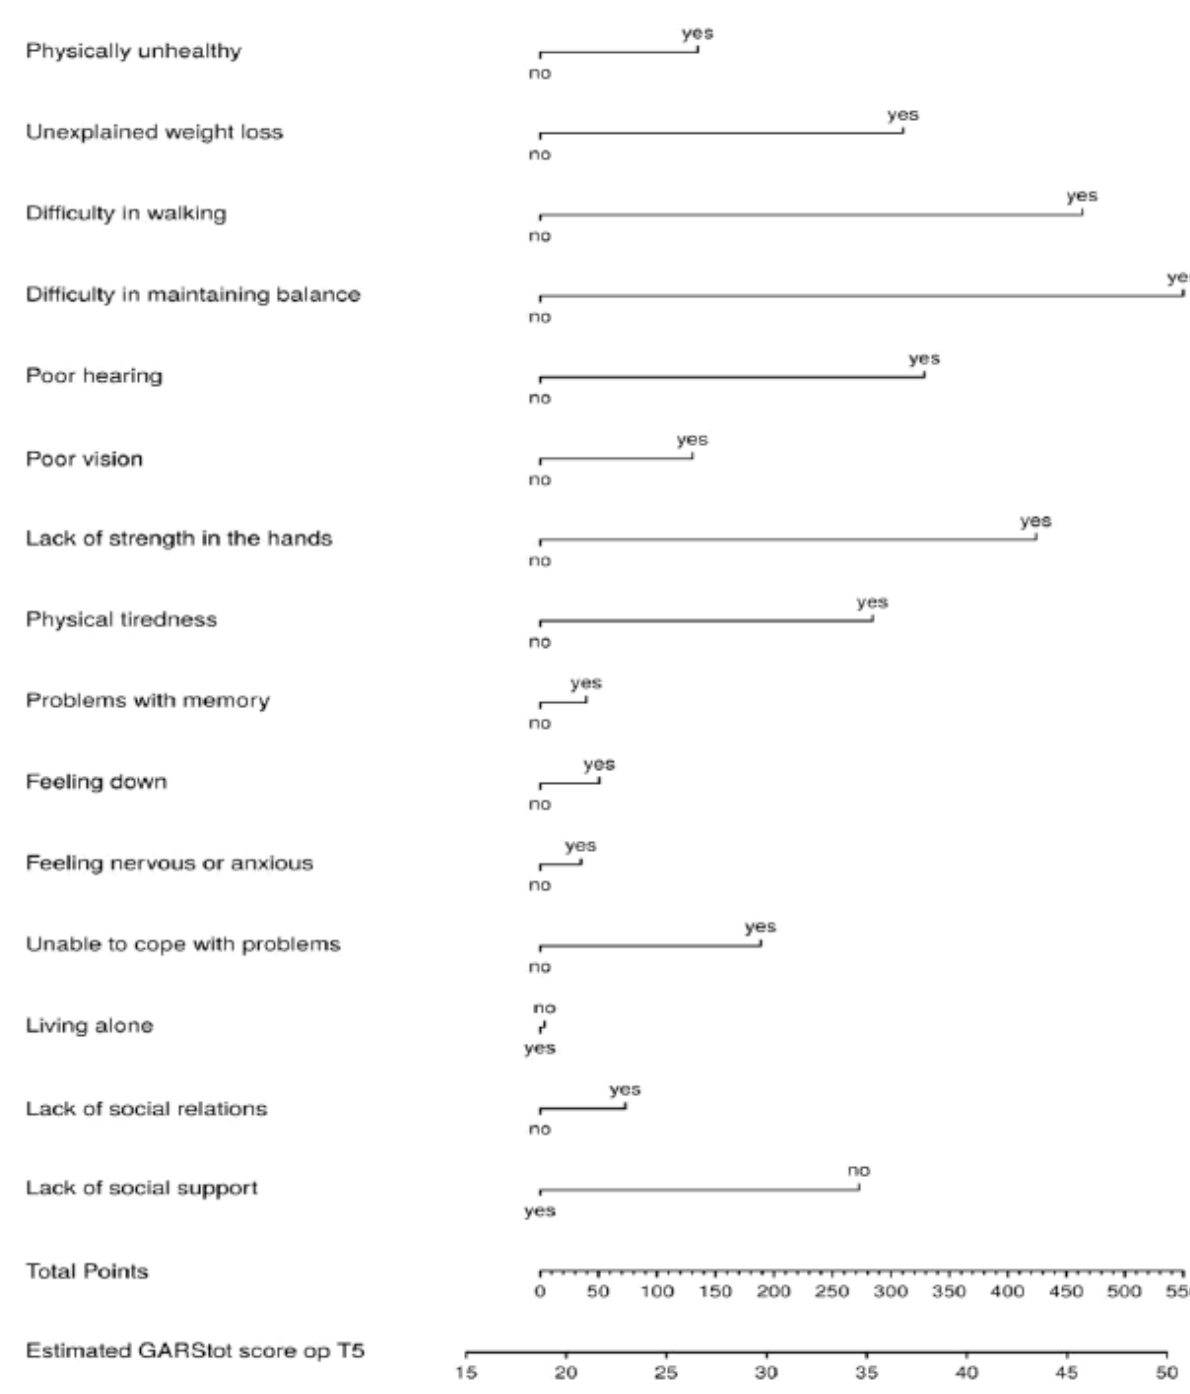
Figure A2. Nomogram total disability score at Figure 2. Nomogram total disability score at T5.